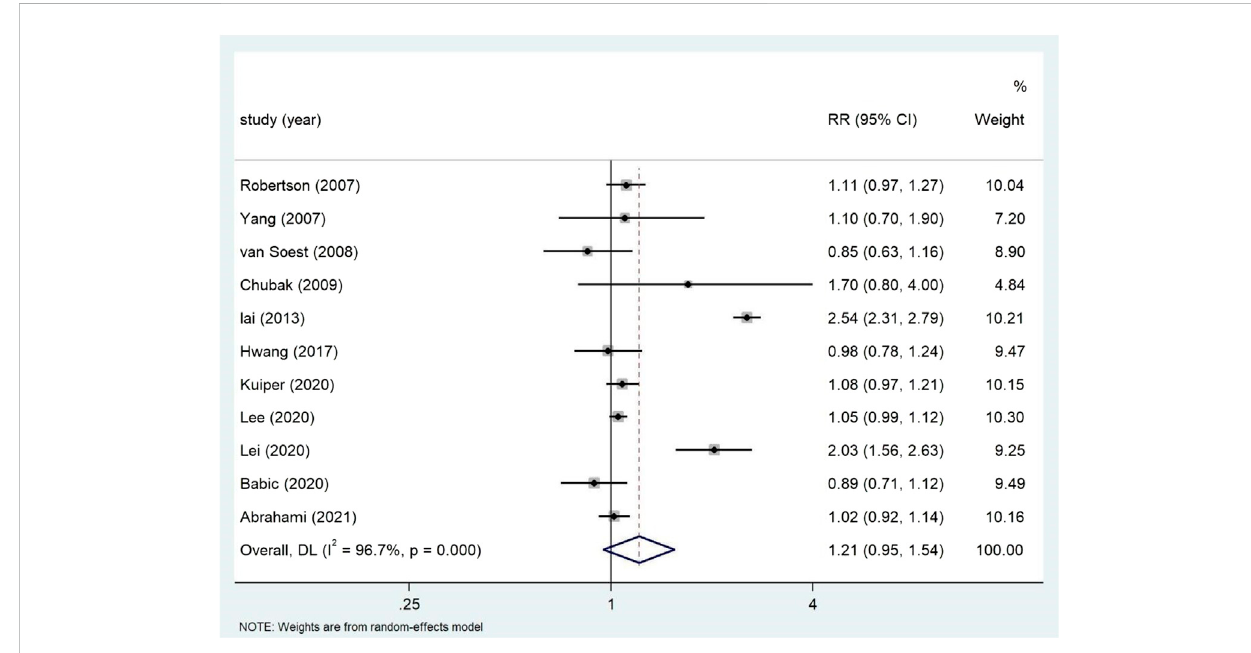
FIGURE 6 Forest plot of long-term use of PPI and the risk of Colorectal Cancer.